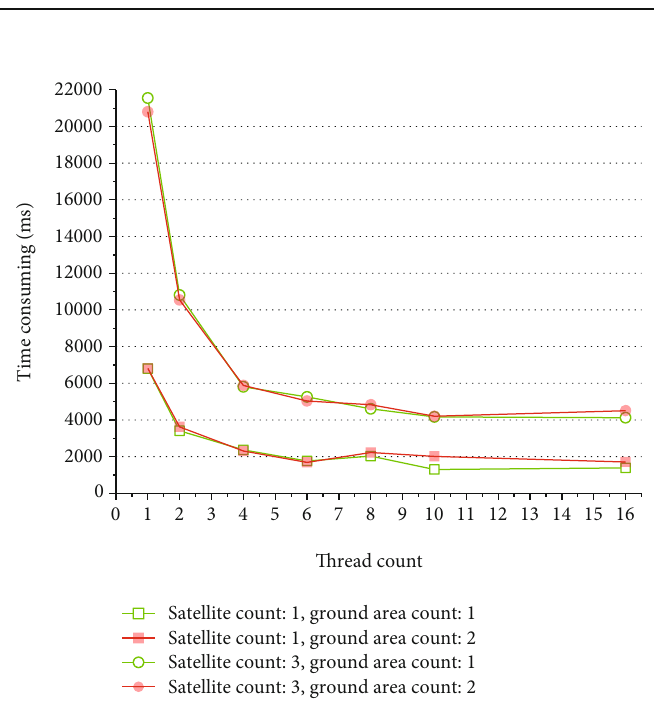
Figure 13: Comparison of time consumption strategies with di ff erent parallel